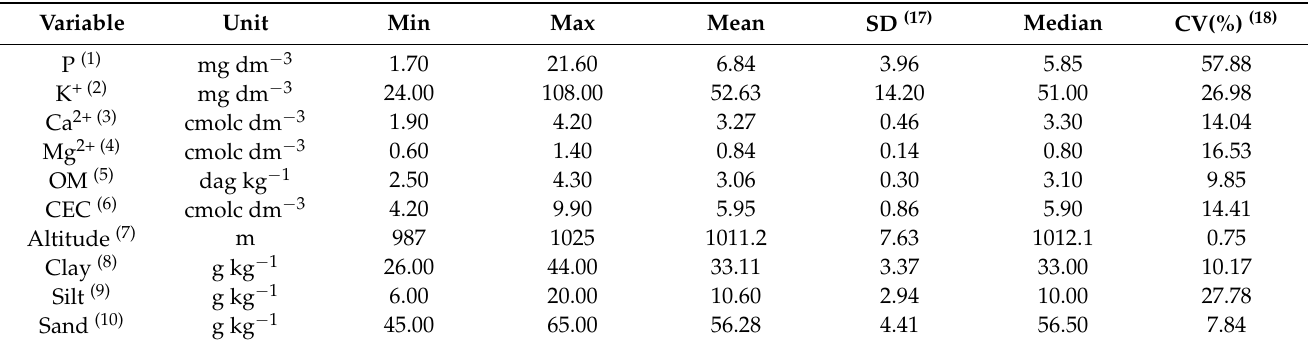
Figure 3. Geographical location of the study area and distribution of sampling points in Anápolis/Goianápolis, Goiás, Brazil. Table 1. Descriptive statistics of soil attributes in the area of